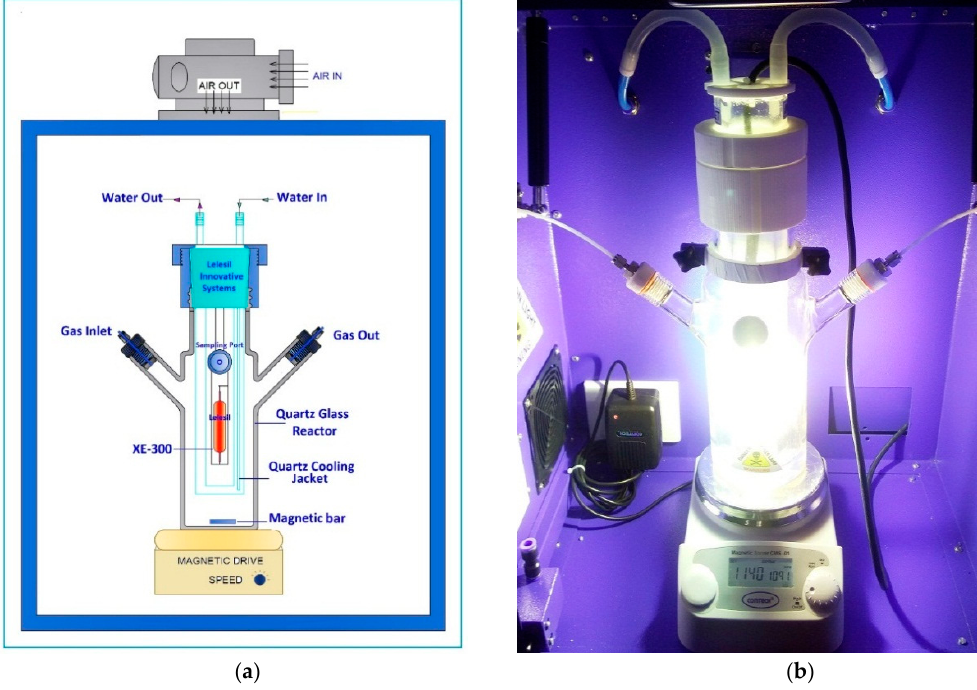
Figure 6. ( a ) Schematic and ( b ) photograph of the reactor used for photocatalytic H 2 production.